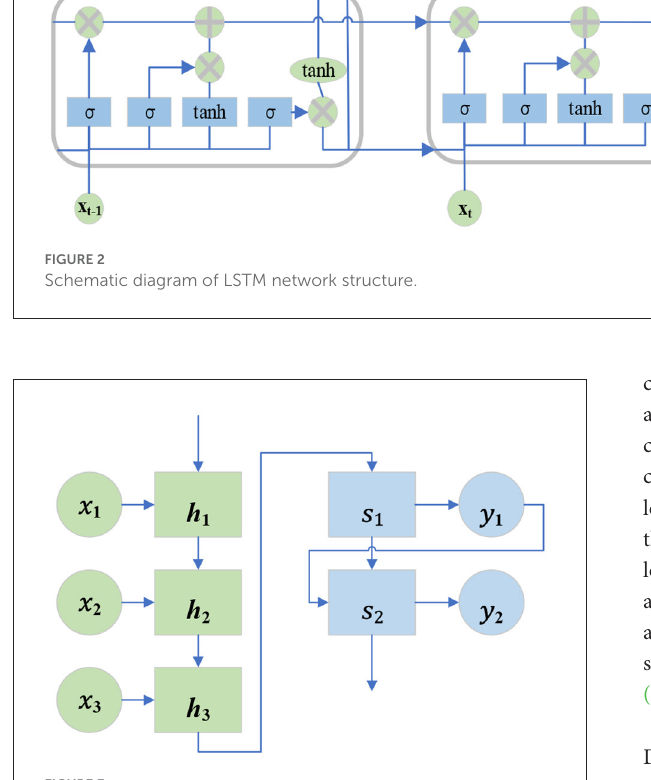
C, which is passed to the decoder as input. At each decoding position j , the content vector c j is the weighted sum of all hidden states of the encoder and their corresponding attention